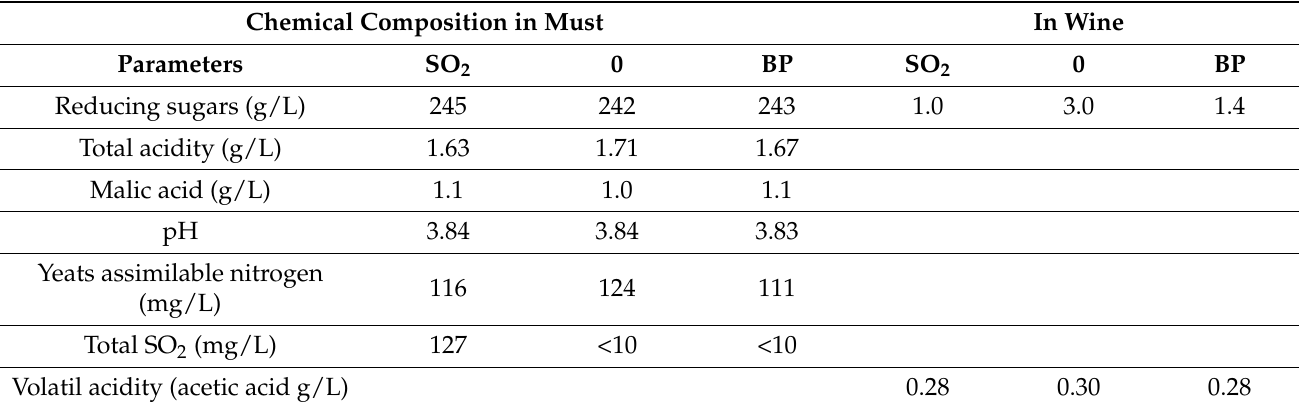
Table A3. Merlot grape must parameters at vatting and wine after alcoholic fermentation analyzed for each modality: SO 2 (added 50 mg/L), without SO 2 (0) and with bioprotection at 50 mg/L (BP). The analyses were performed according to the official methods described by the European Commission. Values correspond to the average of biological